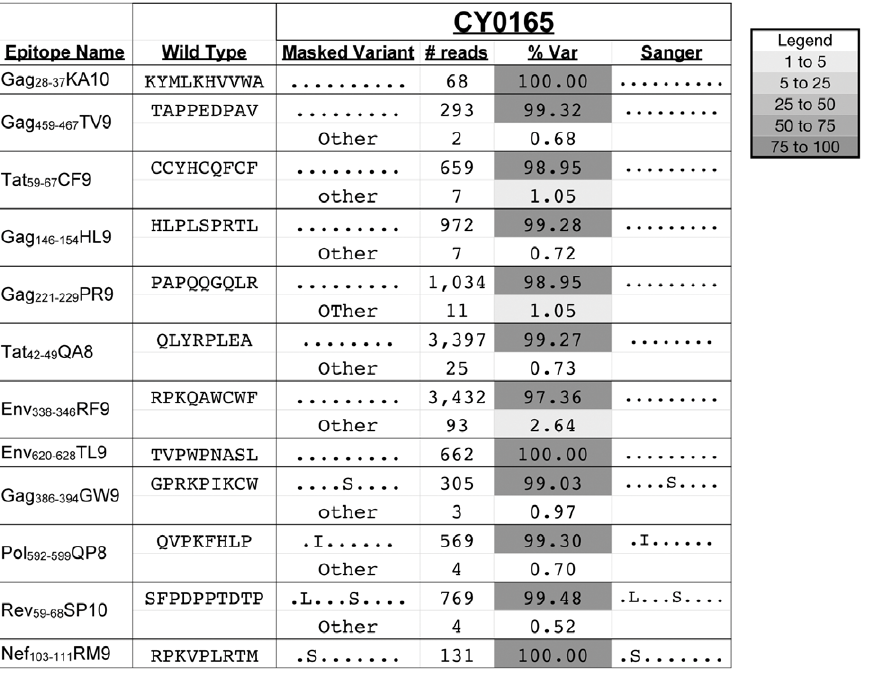
Figure 3. Variation in CD8-TL epitopes in a virus population from an M3/M3 elite controller. Amino acid variation detected by pyrosequencing in 12 CD8-TL epitopes in viruses isolated from CY0165 is compared to variation previously reported by Sanger sequencing bulk PCR amplicons [18]. Sequences that match the inoculum are represented with a ‘‘.’’. The number of high quality reads with each specific sequence is shown. The total number of reads for each epitope can be found in Table S2. The frequency of reads with a specific amino acid sequence is shown as